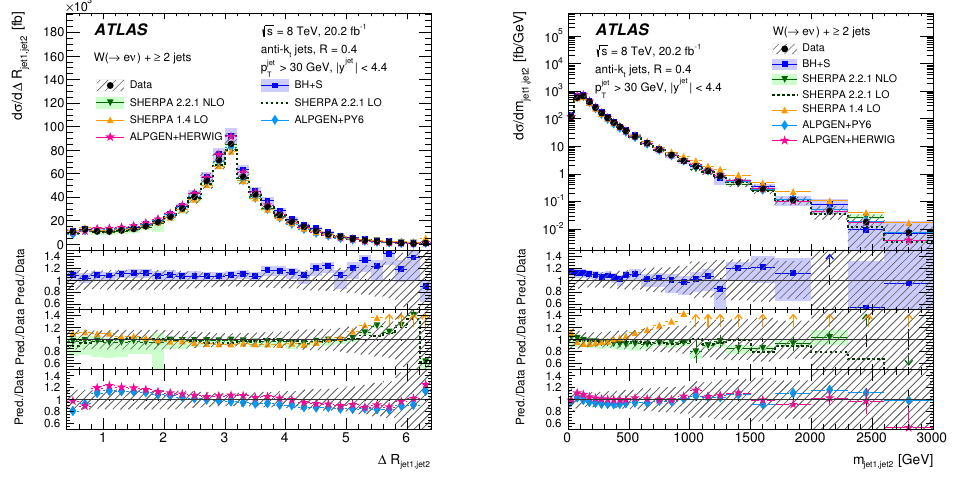
Figure 9 . Di(cid:11)erential cross sections for the production of W + jets as a function of (cid:1) R jet1,jet2 (left) and dijet invariant mass (right) for events with N jets (cid:21) 2. The last bin in both (cid:12)gures includes values beyond the shown range. For the data, the statistical uncertainties are indicated as vertical bars, and the combined statistical and systematic uncertainties are shown by the hatched bands. The uppermost panel in each plot shows the di(cid:11)erential cross sections, while the lower panels show the ratios of the predictions to the data. The theoretical uncertainties on the predictions are described in the text. The arrows on the lower panels indicate points that are outside the displayed